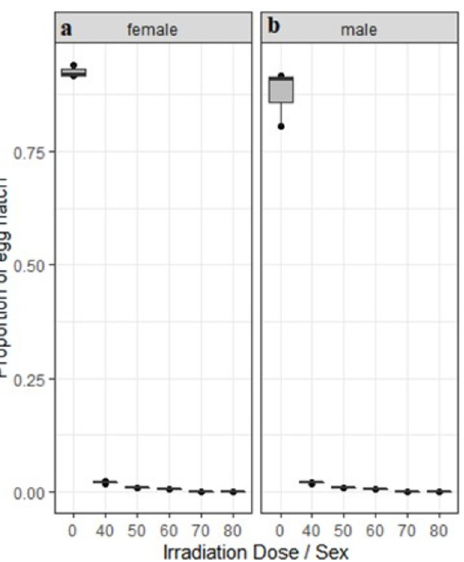
Fig 5. Effects of irradiation on percentage of egg fertility of Ae . aegypti . a Irradiated females mated with non- irradiated males. b Irradiated males mated with non-irradiated females. Each box denotes the median as a line across the middle, the quartiles (25 th and 75 th percentiles), the minimum and maximum values at the ends of the vertical lines. Results are expressed as mean ± SE.